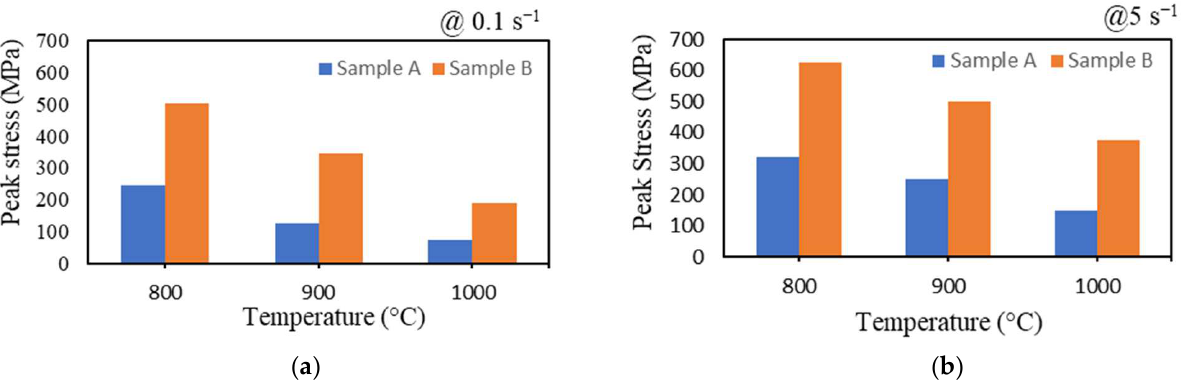
Figure 6. Extracted peak stresses from flow curves for alloys Fe-30.9Mn-4.9Al-4.5Cr-0.4C (Sample A) and Fe-21.3Mn-7.6Al-4.3Cr-1C (Sample B) deformed at different temperatures and constant strain rates of ( a ) 0.1 s −1 ; ( b ) 5 s −1 .